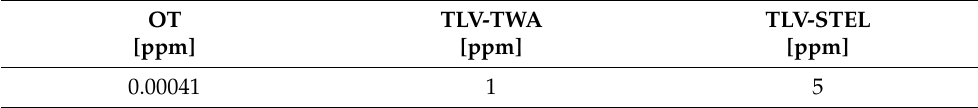
Table 7. OT and TLV values for hydrogen